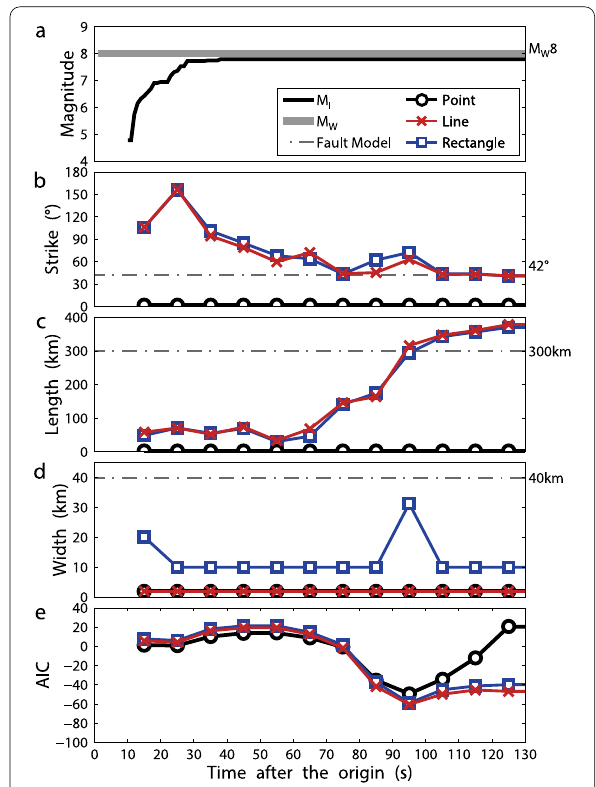
Fig. 9 Time history of the source parameters for the 2008 Wenchuan earthquake. The format is the same as in Fig.